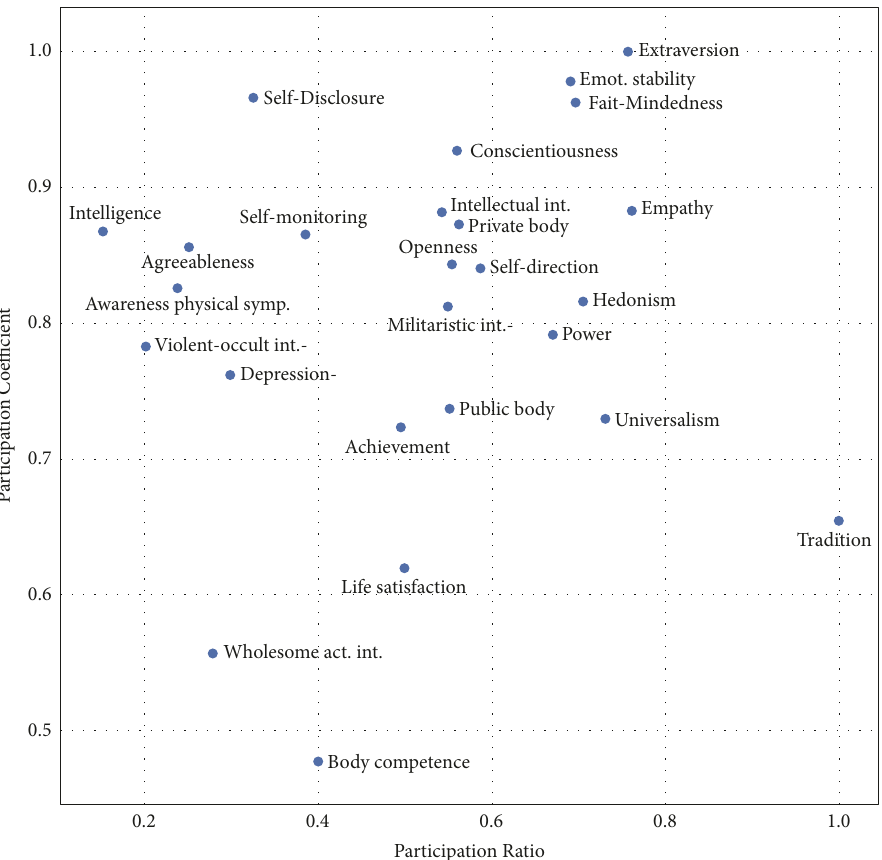
Figure 7: Scatterplot of standardized values of participation coefficient and participation ratio (min-max scale from 0 to 1) for all nodes in the